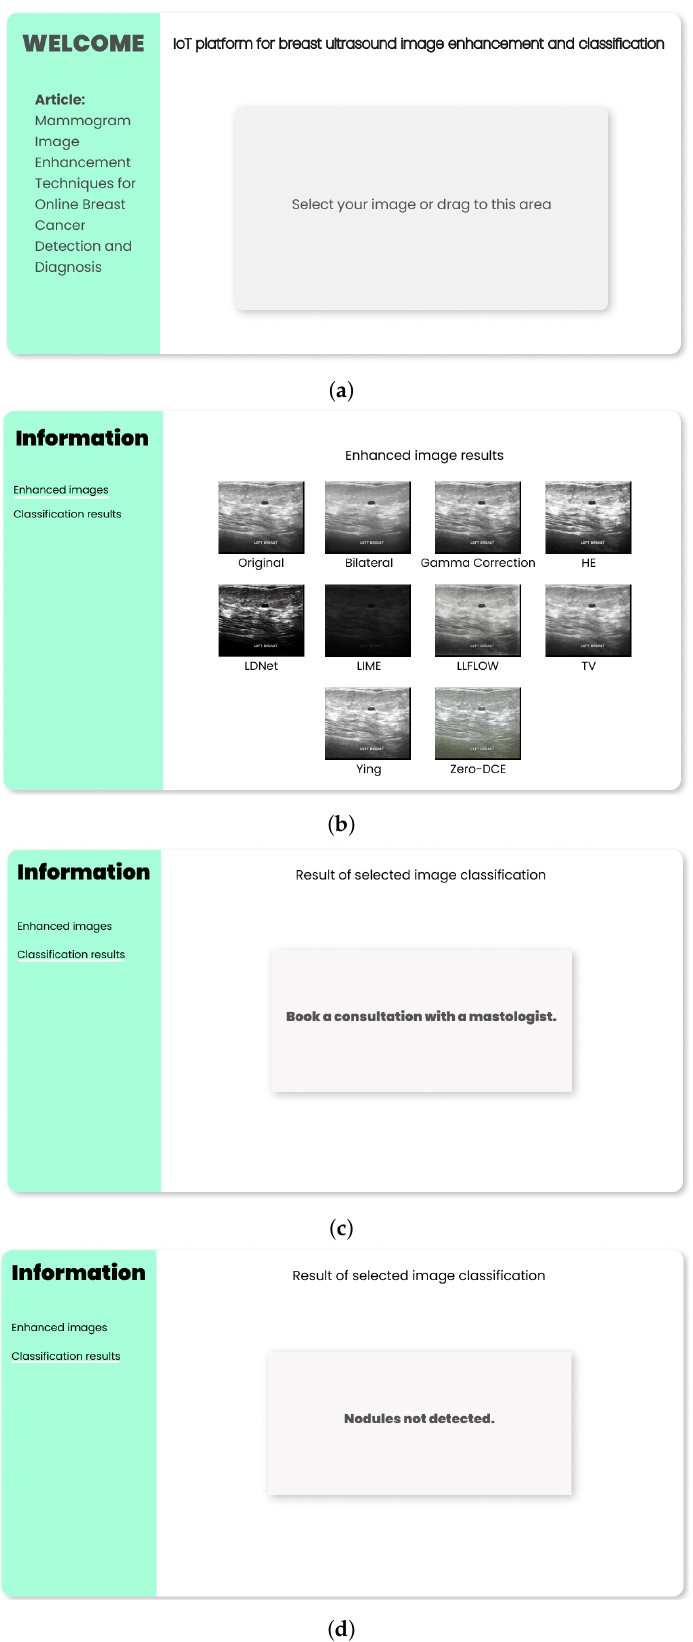
Figure 9. Online web platform interfaces modules. ( a ) Main interface module ( b ) Module with images enhancement ( c ) Classification module with nodules ( d ) Nodule-free sorting